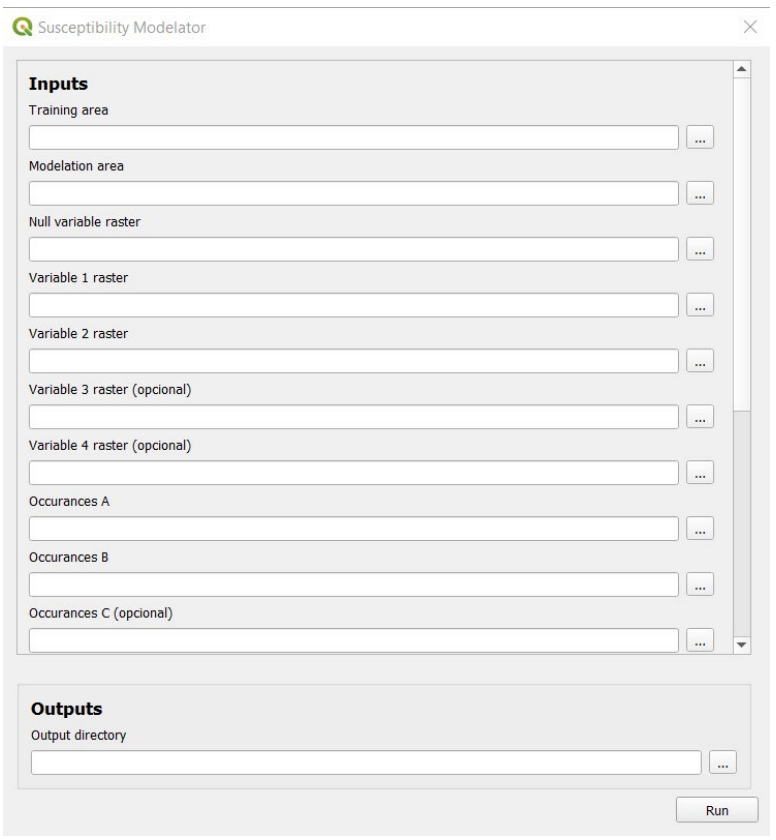
Figure 4. GUI of the “Susceptibility modelator” plugin.